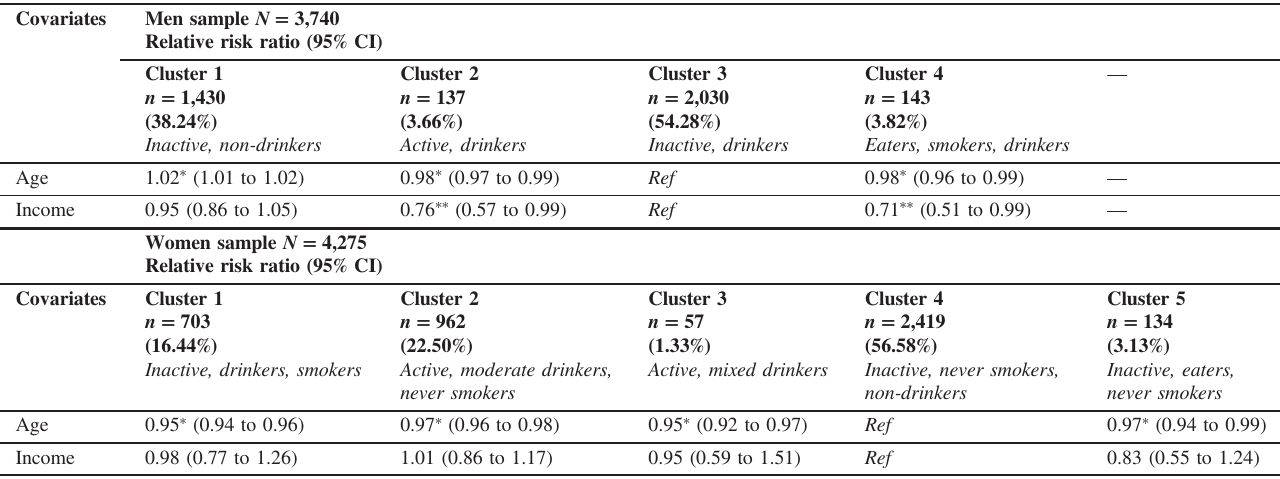
Table 3. Multinomial logistic regression model estimating association between cluster membership and socio-demographic factors, adjusting for classi fi cation error